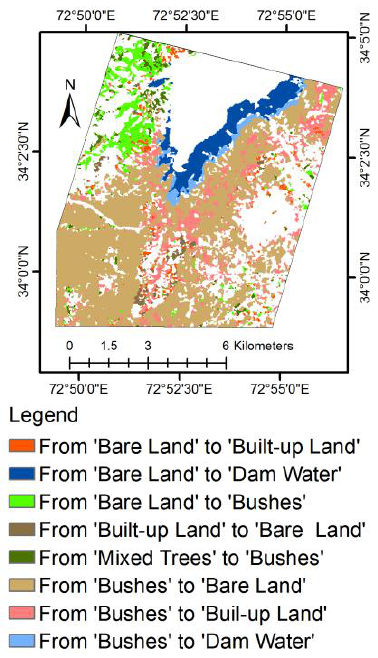
Figure 7. Change detection results of OLI SVM classified data from spring to autumn